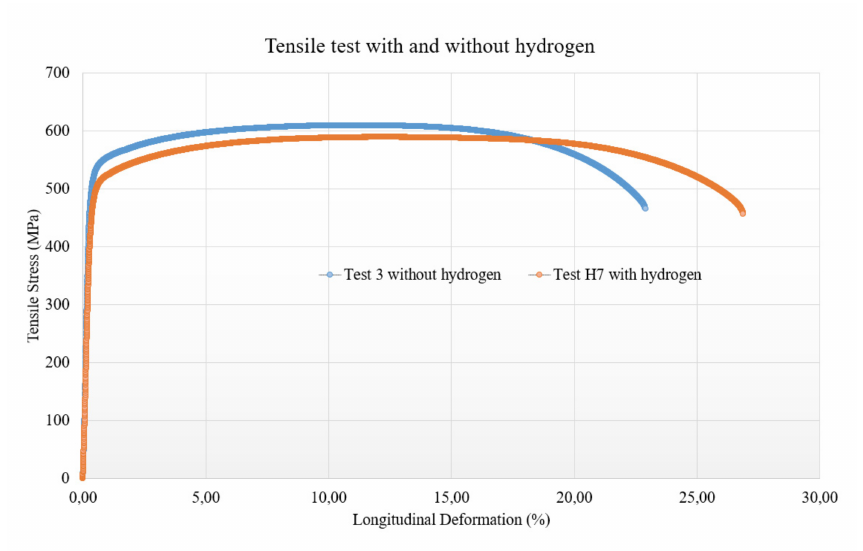
Figure 3. Stress–strain curves for API 5L X52 steel, the effect of HE. Degradation of toughness increases the risk of gas line failure, loss of life, environ- mental damage, and economic loss associated with the repair of affected lines and loss of